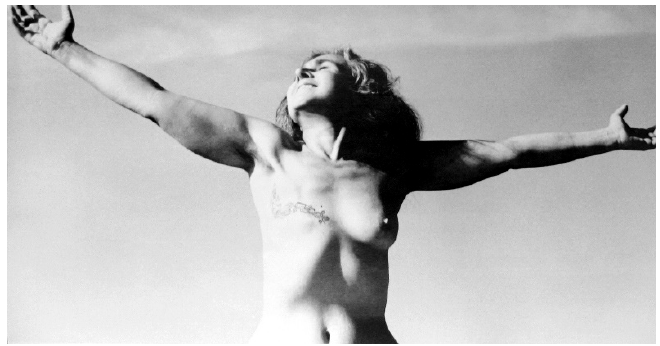
Figure 1. Deena Metzger, The Warrior , photograph by Hella Hammid, 1977. Courtesy of Deena Metzger and the Estate of Hella Hammid.